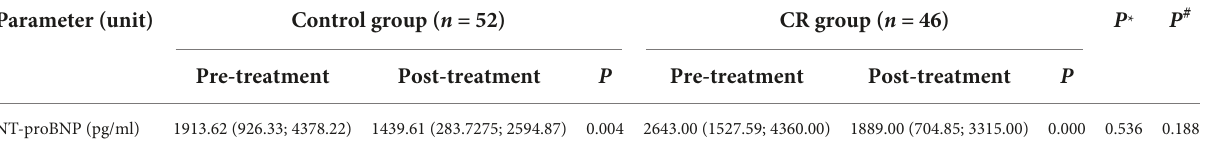
TABLE 3 Comparison of NT-proBNP of patients with CHD and AHF before and after the treatment.